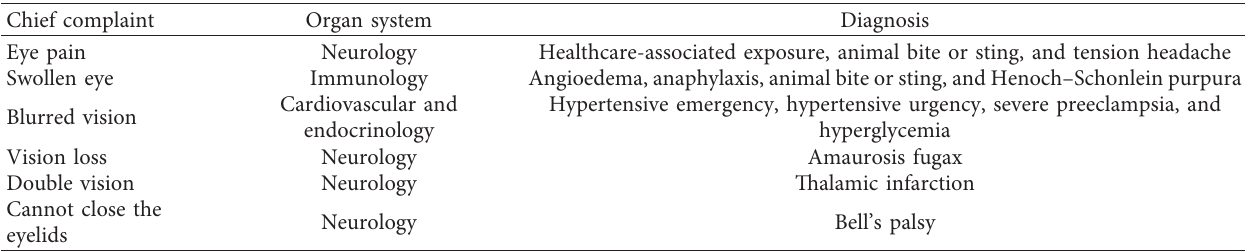
Table 6: Characteristics of noneye disease classified by the group of diagnoses.